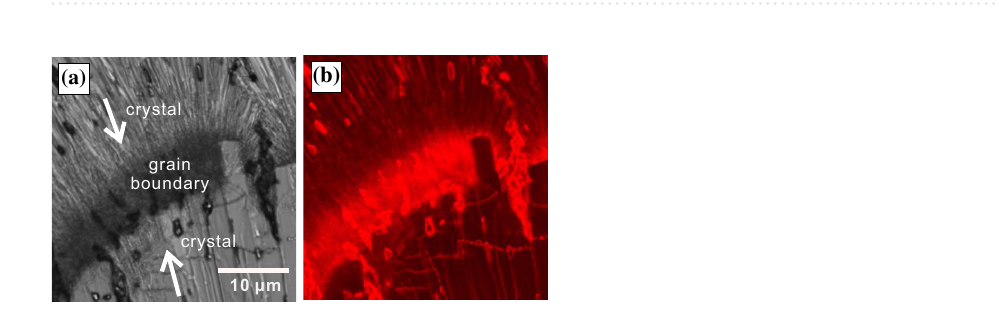
Figure 6. Crystal morphologies in ( a ) pure OTP, ( b ) OTP with 1 wt% toluene, and ( c ) OTP with 1 wt% acetone at 283 K. Filamentous crystal growth with bubbles is observed in pure OTP; when a small amount of toluene or acetone is mixed in, there are no bubbles and only faceted crystal growth is observed.